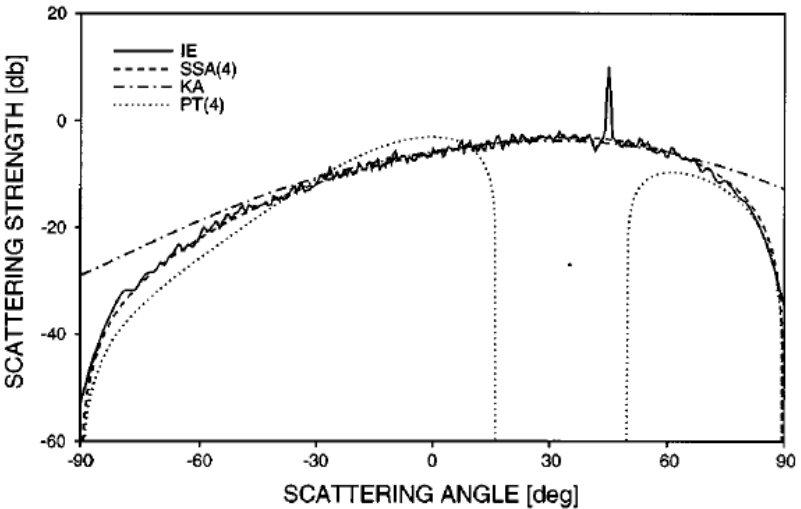
Figure 11. Thorsos’ Figure 6 [112]. Comparison of the SSA(4), KA, PT(4) and IE scattering strengths for a case when neither PT(4) nor the KA is accurate. Here, k σ = 1.0, kL = 4.3, γ = 18.2 ◦ , and θ i = 45 ◦ . Reproduced with permission from [112], AIP Publishing, 1997.